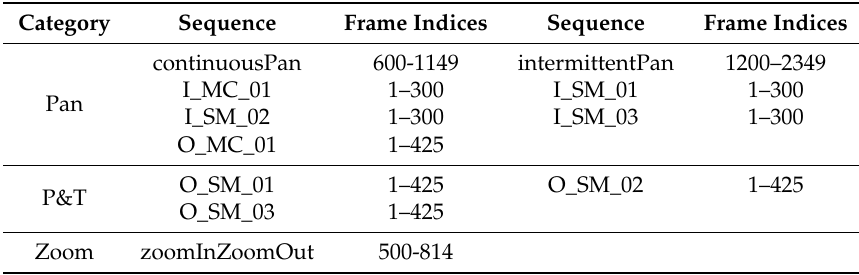
Table 4. Categories, scenes, and frame indices of testing